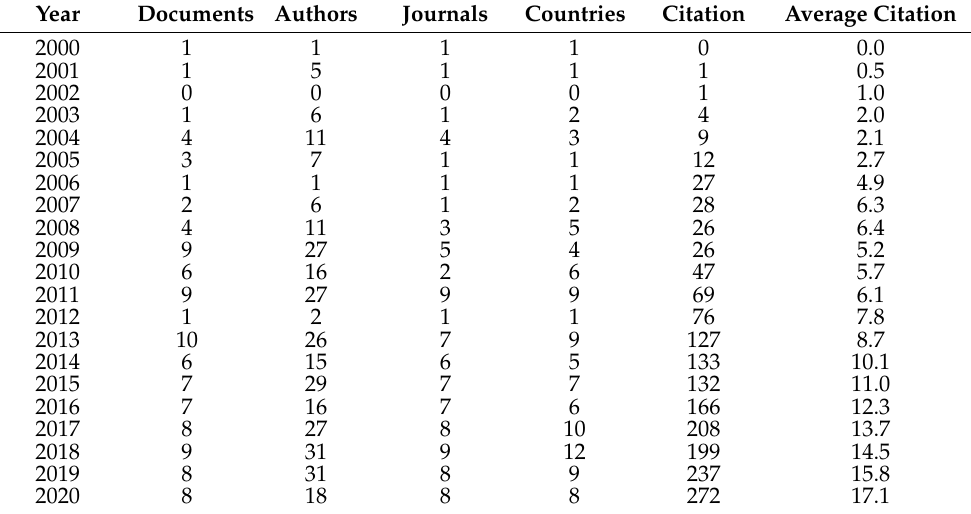
Table 1. Main characteristics of the EEA